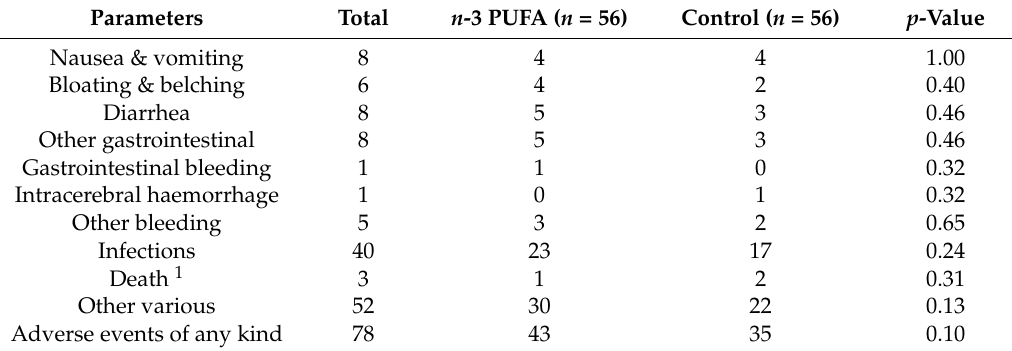
Table 4. Adverse